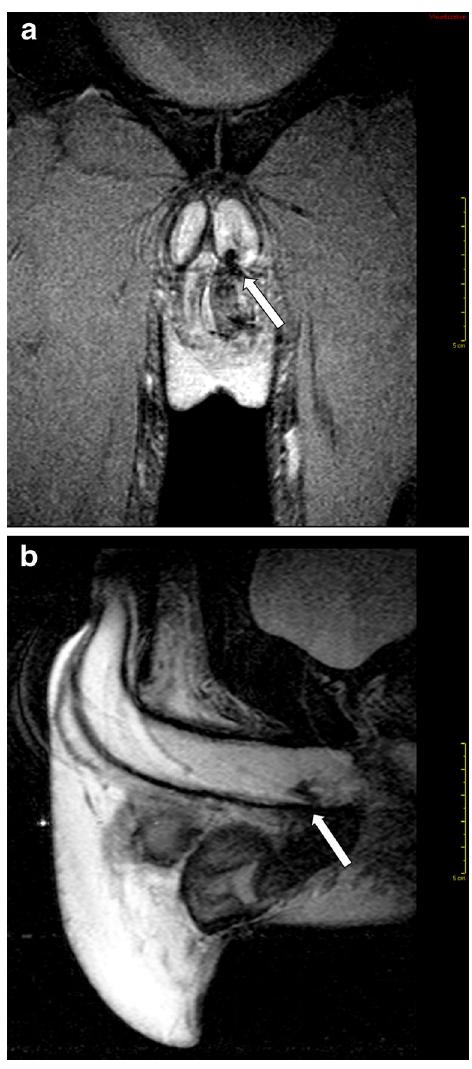
Fig. 2 a - b Intrascrotal rupture of the corpus cavernosum (arrow). a T2- weighted FFE sequence, coronal view; b T2-weighted SPIR TSE sequence, sagittal